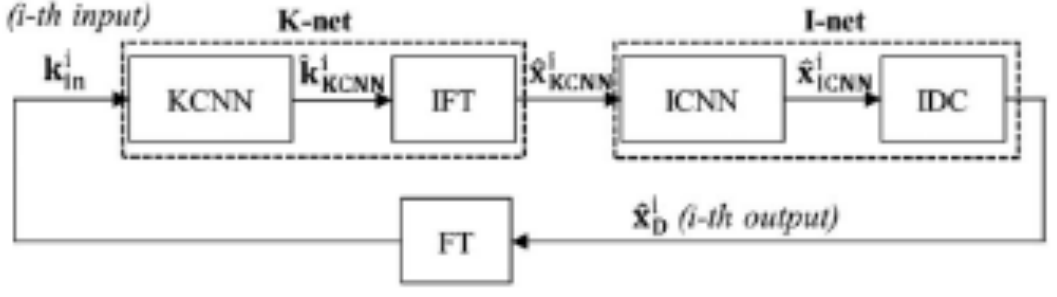
Figure 4. Illustration of the KIKI-net from [10]. The KCNN and ICNN are convolutional neural networks composed of a number of convolutional blocks varying between 5 and 25 (we implemented 25 blocks for both KCNN and ICNN), each followed by a ReLU non-linearity and featuring between 8 and 64 filters (we implemented 32 filters). For both the varying numbers, the supplementary material of [10] shows that the higher the better. The ICNN also features a residual connection.